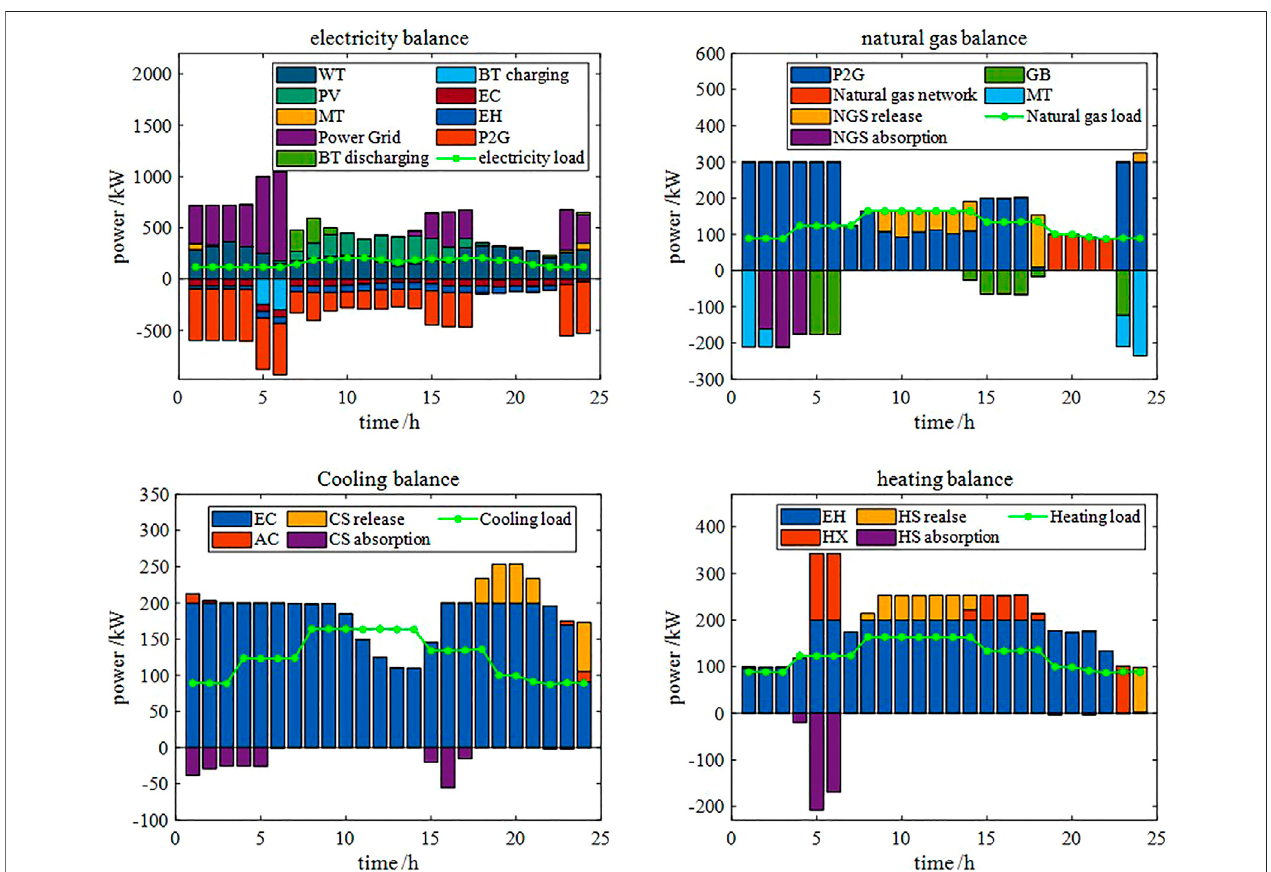
FIGURE 9 | Power balance in Case